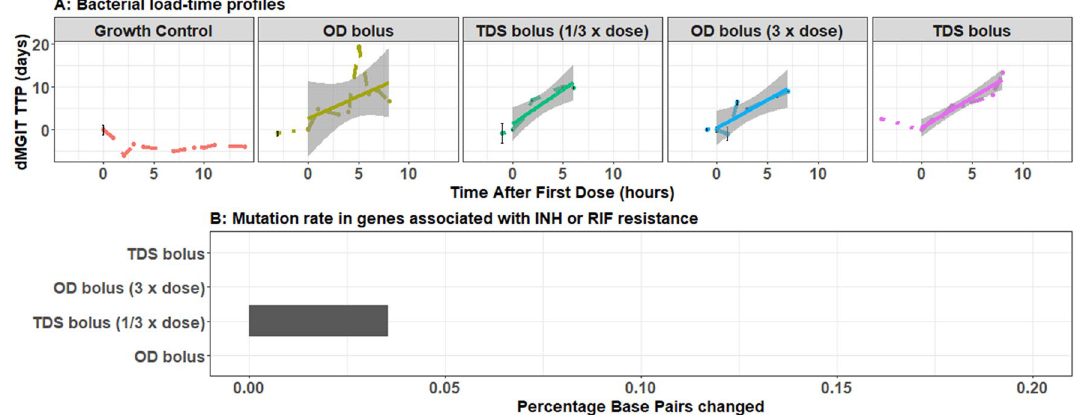
Figure 3. Bacterial killing in the HFIM. Bacterial growth and killing after four different dosing regimens simulated in the HFIM ( A ). Mutation rate for genes associated with isoniazid or rifampicin resistance ( B ). Dots, error bars and dashed lines in panel A represent observed dMIGIT TTPs, their uncertainty based on technical repeats where available and the connections between them while the solid lines and shaded areas represent the linear model fits with standard errors. HFIM, Hollow Fibre Infection Model; OD, Omnie die ; TDS, Ter Die Sumendus and mutation rate: base pair changes relative to the H37Rv reference genome for 6 genes of interest associated with